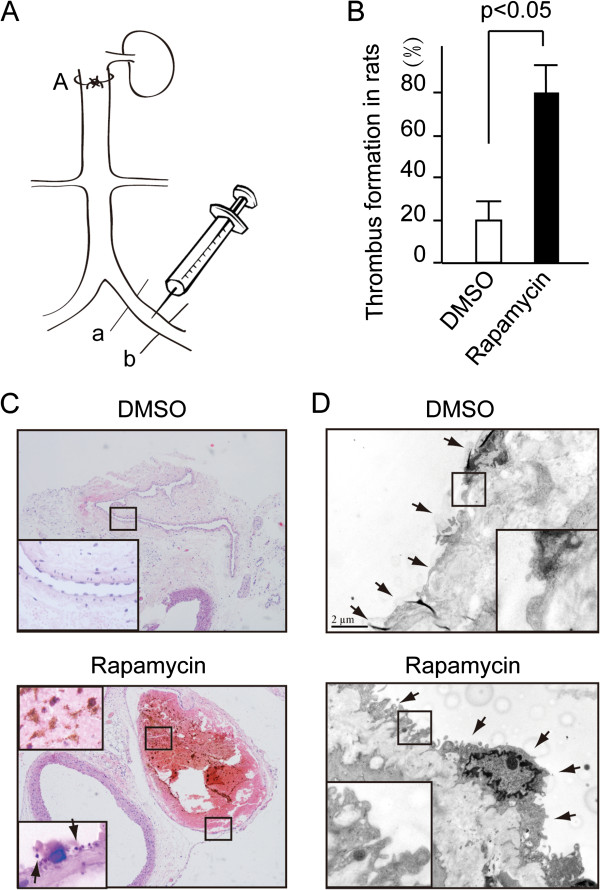
Rapamycin promoted thrombosis in rats. (A) The diagram of the DVT rat model illustrated that the iliac vein which was tied at site A was injected with rapamycin or DMSO and then tied tightly at the sites of a and b. (B) The ratio of thrombosis in rapamycin group (80%) is far more than that in DMSO (20%) group. n = 10 in each group. (C) HE staining exhibited thrombosis in the venous lumen at the time of the 40th minute. Enlarged squares indicate the platelet-derived clot appeared in the thrombus. (D) Transmission electron microscope analysis exhibited microvilli-like structure on endothelial of rapamycin treated rats compared with the smooth endothelial surface in the DMSO treated rats (TEM × 10, 000).